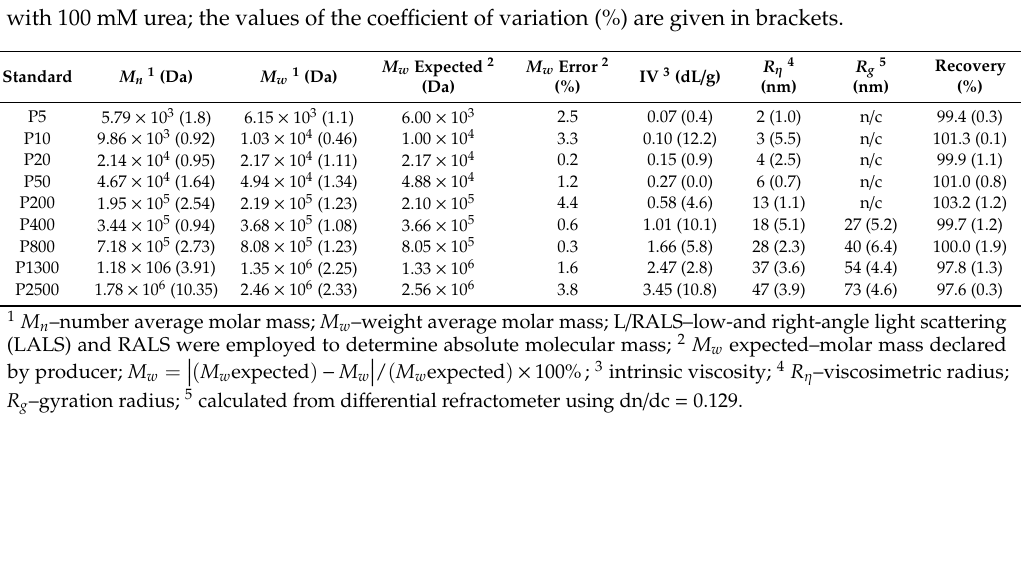
Table 1. Molar masses and hydrodynamic parameters of pullulan standards (P5–P2500, Shodex,